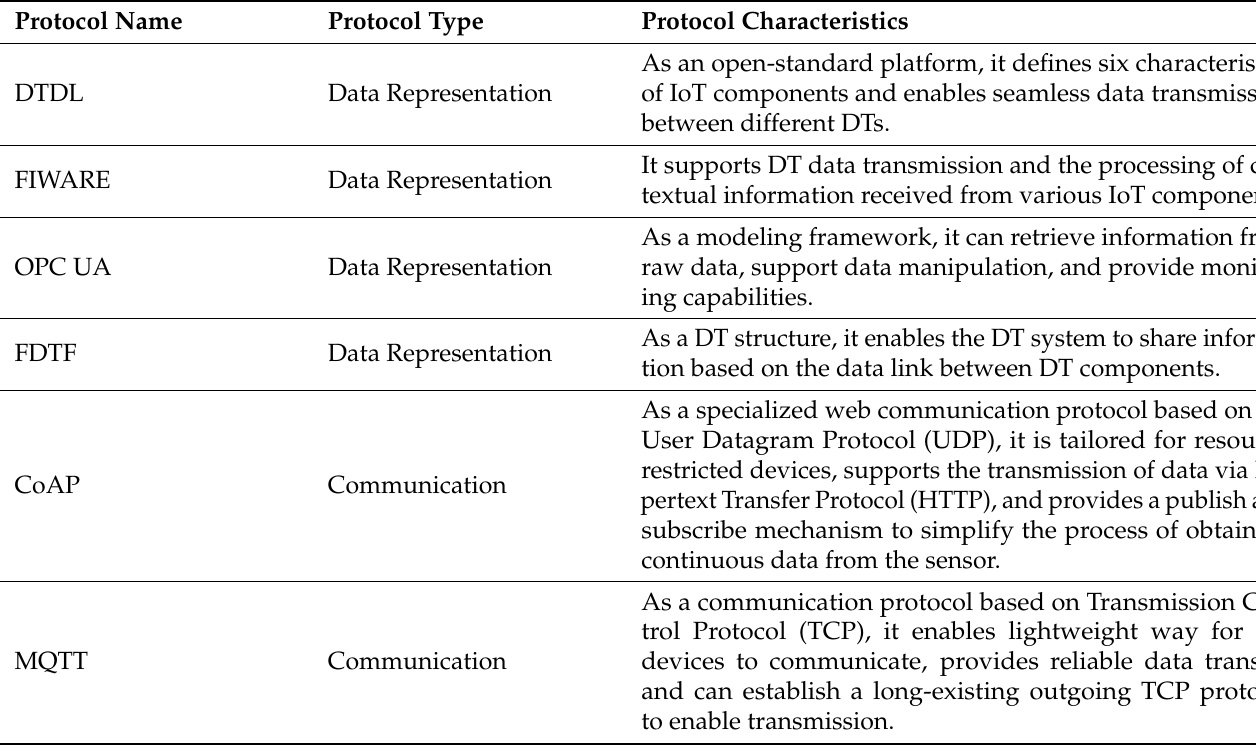
Table 1. Protocols of